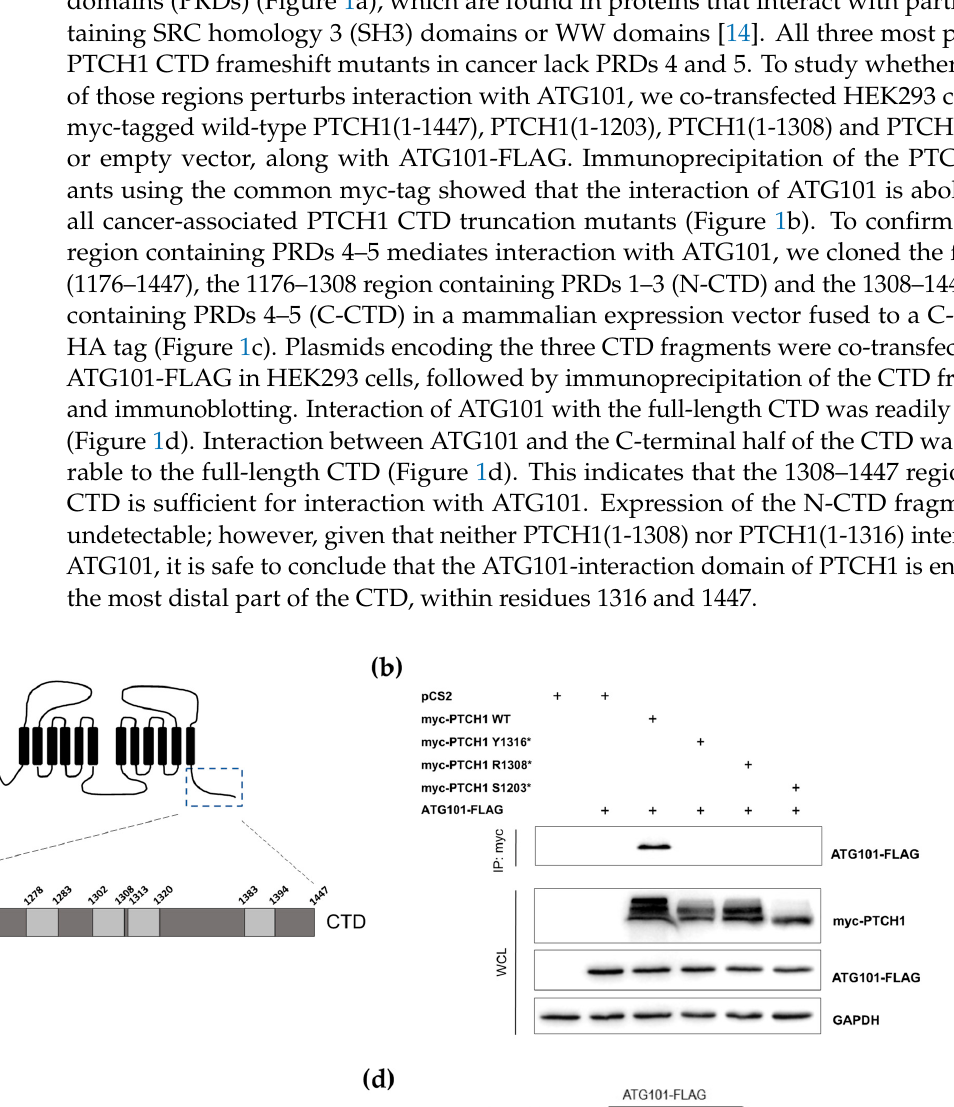
(Supplementary Table S2): PTCH1 S1203fs, PTCH1 R1308fs and PTCH1 Y1316fs. All